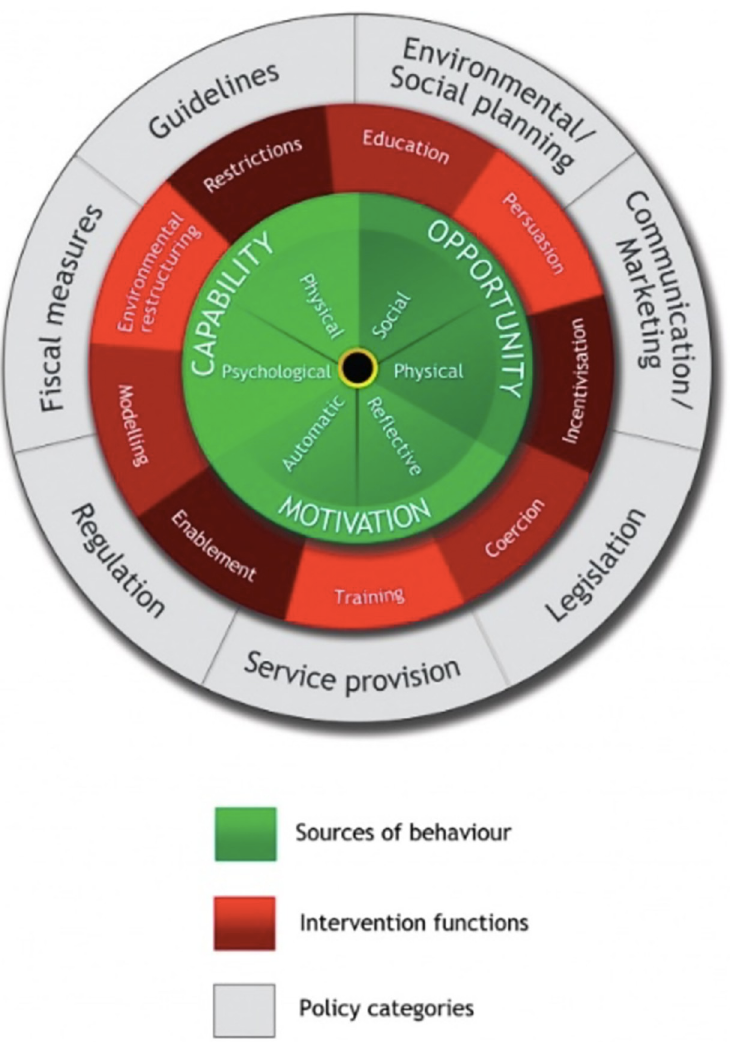
Fig 12. Behavioural change